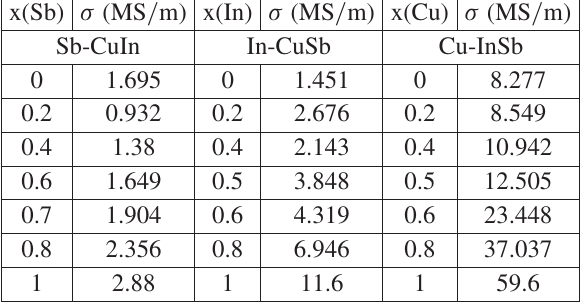
x(Sb) (cid:5) (MS = m) x(In) (cid:5) (MS = m) x(Cu) (cid:5) (MS = m)